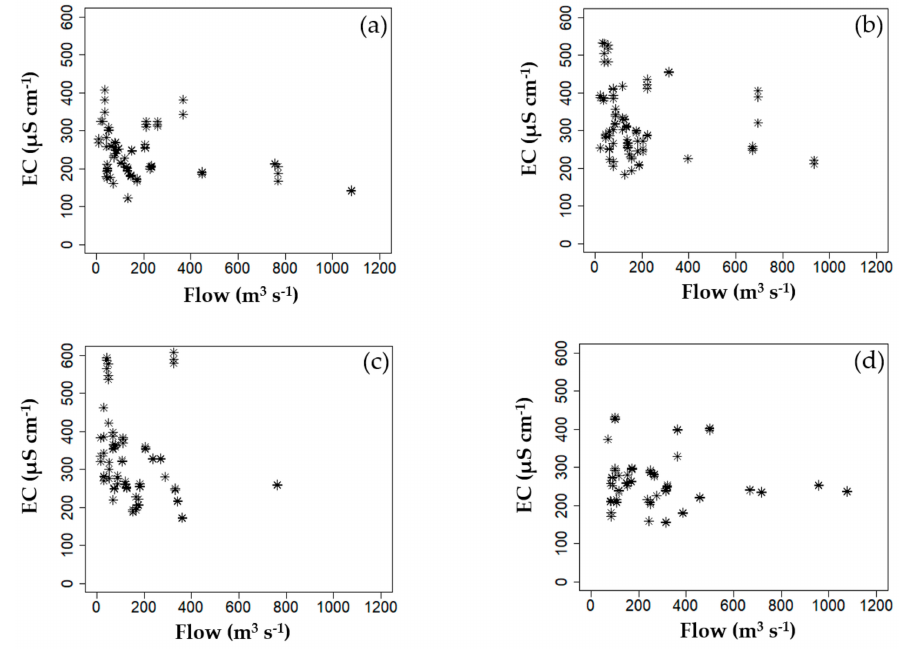
Figure 7. Correlation between electrical conductivity (EC) ( µ S cm − 1 ) and flow rate (m 3 s − 1 ) at; ( a ) Gangjeong Goryeong weir (GGW), ( b ) Dalseong weir (DSW), ( c ) Hapcheon Changnyeong weir (HCW), and ( d ) Changnyeong Haman weir